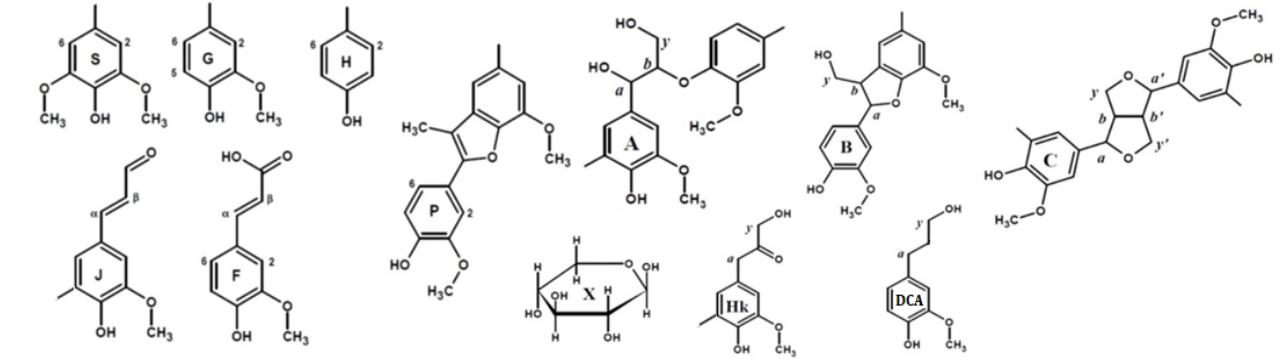
Figure 2. Principal structures and components present in the dioxane lignins of birch phloem as identified in the 2D HSQC NMR spectra A: β –aryl ethers; B: phenylcoumaran; C: resinols; Hk: Hibbert’s